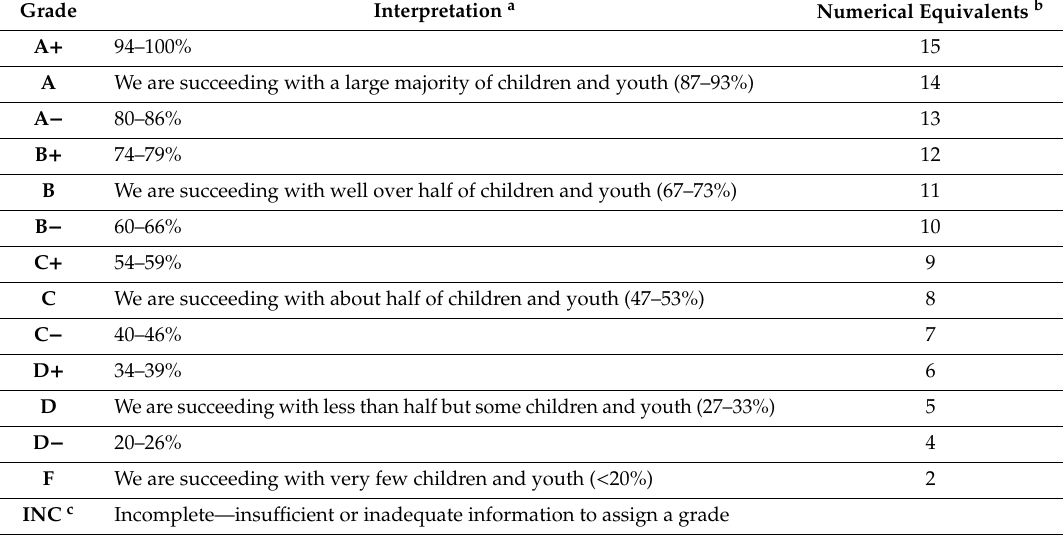
Table 1. Global Matrix 3.0 grading